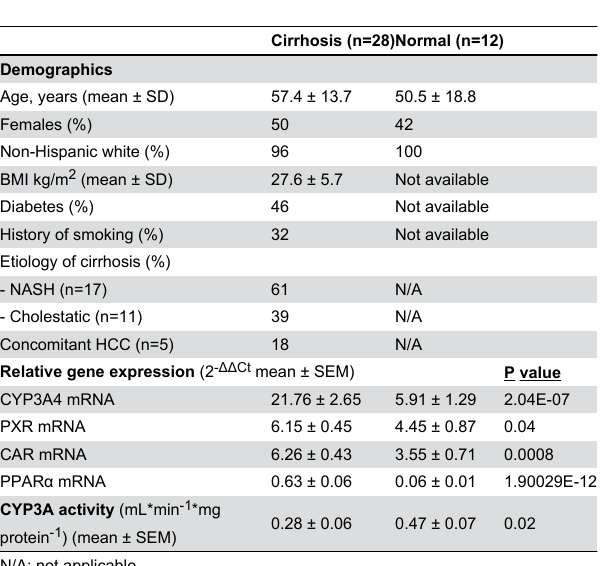
Table 1. Select demographics, gene expression and CYP3A activity in study